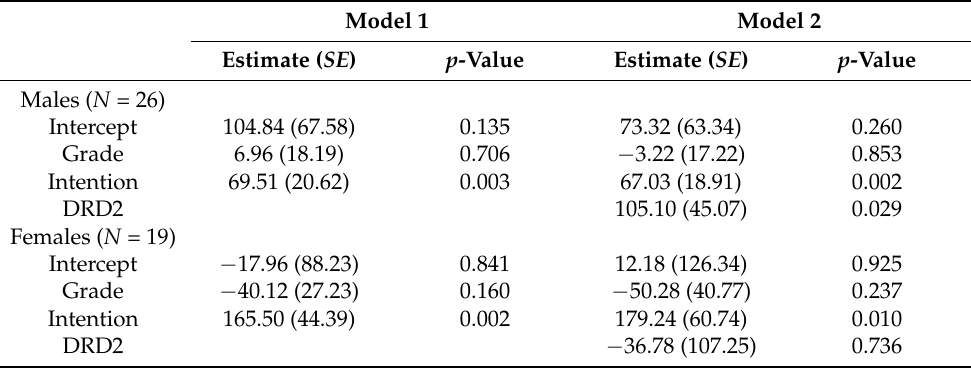
Table 2. The effects of intention and the A1 allele of DRD2 on sport participation, and the interactions between